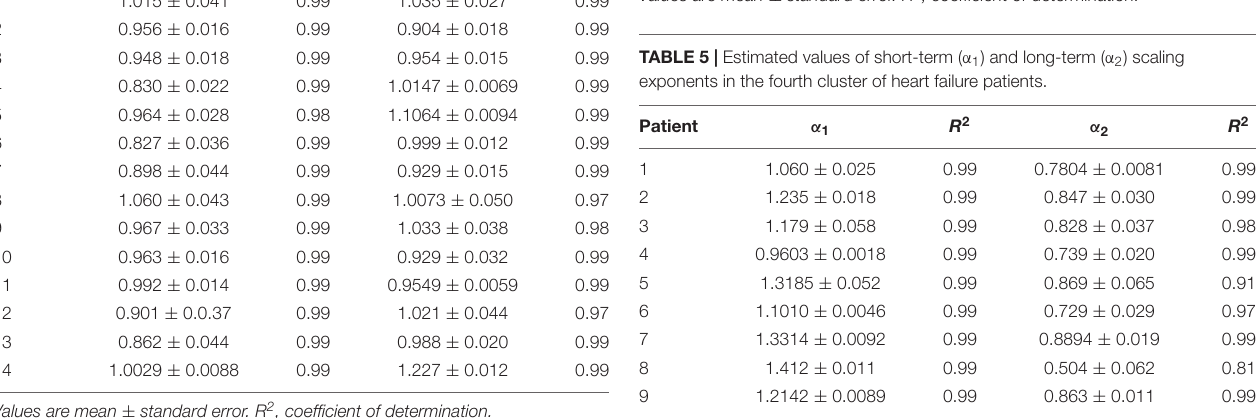
Values are mean ± standard error. R 2 , coefficient of determination.